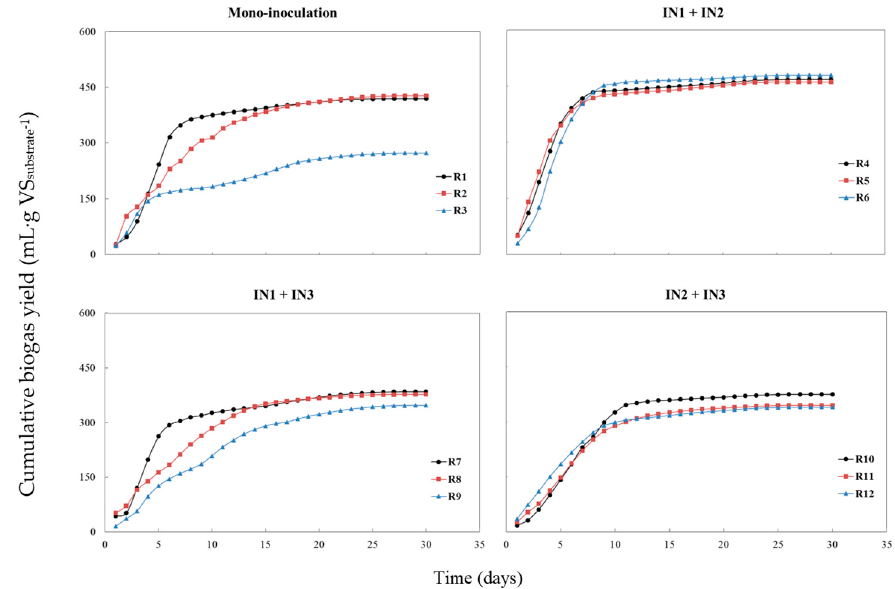
Figure 2. The cumulative biogas production for PFSF inoculated with three different inoculums and their mixtures (IN1, digestate from the reactor treating the activated sludge; IN2, digestate from the reactor treating the organic fraction of MSW; and IN3, digested cow manure).